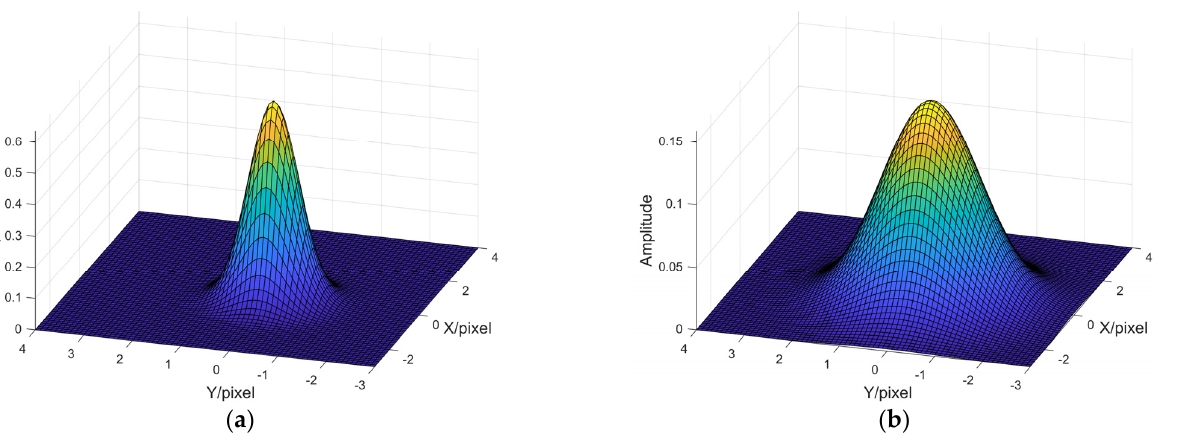
Figure 5. The infrared radiation intensity signal and infrared irradiance signal of 8–12 µ m. ( a ) Infrared radiation intensity; ( b ) infrared irradiance signal.